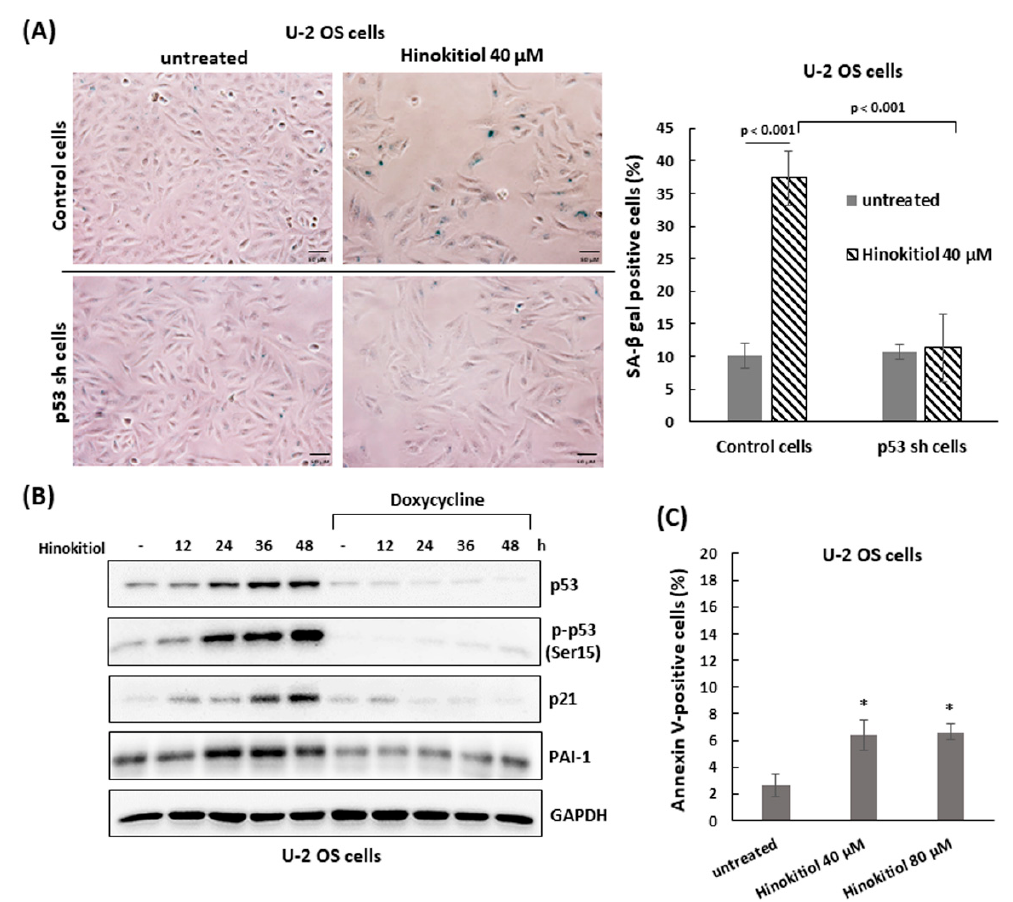
Figure 4. Hinokitiol triggers p53-dependent senescence in U-2 OS cells. ( A ) Hinokitiol enhances activity of senescence-associated β -galactosidase (SA- β -gal) in U-2 OS cells. Control and shp53 U-2 OS cells were incubated with hinokitiol (40 µ M) for 48 h. Senescent cells were determined through SA- β -gal staining. Quantitative results of SA- β -gal-positive cells (blue color) are shown in the right panel. ( B ) Hinokitiol up-regulates p53 expression in U-2 OS cells. Control or shp53 U-2 OS cells were incubated with hinokitiol (40 µ M) and collected at the indicated time points. Western blotting was used to analyze the level of p53, phospho-p53 (Ser15), PAI-1, and p21. ( C ) A small fraction of cells undergoes apoptosis in hinokitiol-treated U-2 OS cells. The cells were incubated with hinokitiol for 48 h. The number of apoptotic cells was determined by double staining of Annexin V and PI using flow cytometry. Quantitative data of Annexin V positive cells is revealed. * p < 0.001.